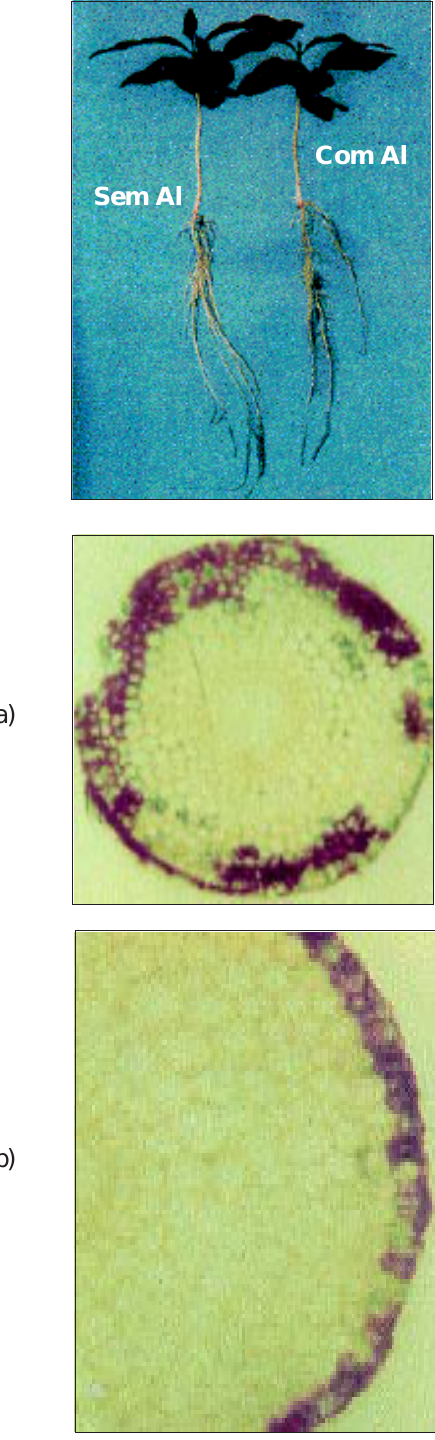
Figura 2. Desenvolvimento do sistema radicular do Robusta (UFV 514) na ausência e na presença de alumínio, em solução nutritiva, e cortes transversais da ponta de raízes de genótipos de café, após 20 h de exposição ao alumínio, na concentração de 0,296 mmol L -1 , e coloridas com hemotoxilina. (a) tolerância intermediária (Icatu, IC 4042) e (b) tolerante (Icatu, IC